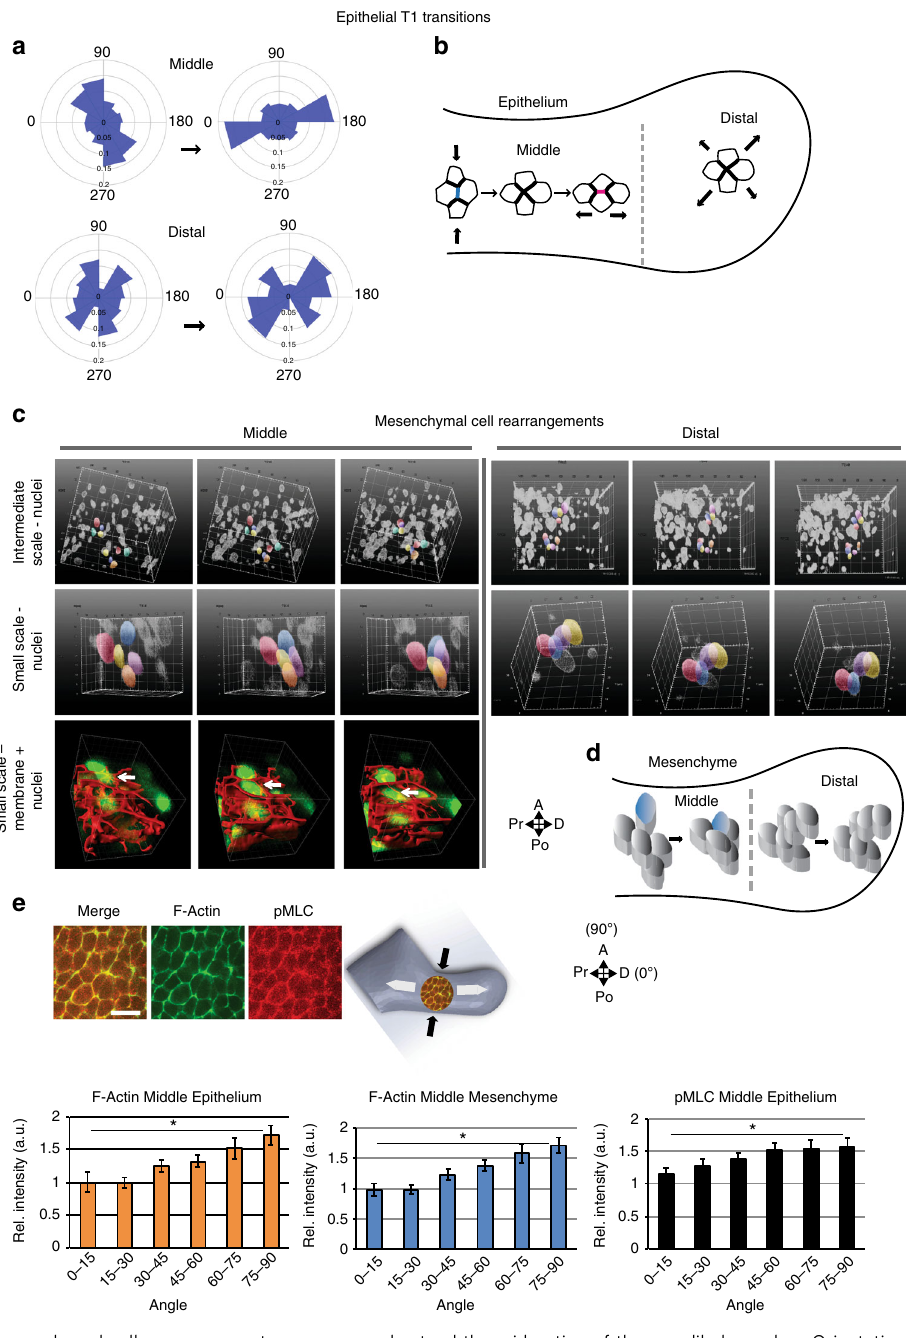
Fig. 3 Epithelial and mesenchymal cell rearrangements converge and extend the midportion of the mandibular arch. a Orientation of epithelial tetrads during T1 transitions at formation to resolution stages (separated by an arrow); n = 3 embryos at 21 somite stage. b Schematic representation of predominant orientation of epithelial T1 transitions in middle and distal regions. c Time series (taken from 120 min. time lapse moves) of volumes of mesenchymal cells of dual H2B-GFP;mTmG transgenic embryos visualised by light sheet microscopy at intermediate and high magni fi cation. Select nuclei are coloured to show tissue and cell convergence at intermediate and small scales occurs in the middle, but not distal, region. (Representative of 5 embryos at 19 – 21 somite stage). d Schematic representation of oriented mesenchymal cell intercalations transverse to the axis of elongation in the middle region. e In the mid-portion of the arch, F-actin and phosphomyosin light chain (pMLC) were biased along proximal and distal epithelial and mesenchymal cell interfaces which is parallel to the rostrocaudal axis and to the direction of cell intercalations. The angular distribution of immunostain fl uorescence intensity for epithelial ( n = 4 embryos) and mesenchymal ( n = 4 embryos) F-actin and epithelial phosphomyosin light chain (pMLC) ( n = 5 embryos) relative to the arch long axis that was designated as 0 o was quanti fi ed in the middle region using SIESTA. Scale bar: 20 μ m, asterisks denote p < 0.05, Student ’ s t -test, error bars denote s.e.m. Source data are provided as a Source Data fi